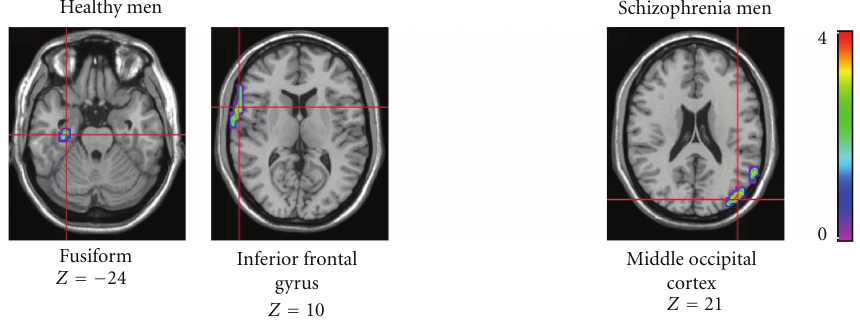
Figure 1: Correlation between progesterone levels and brain activations during processing of positive images.